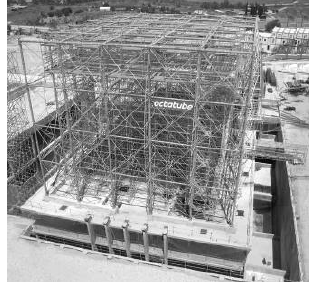
Figure 18: Installation of the Glass